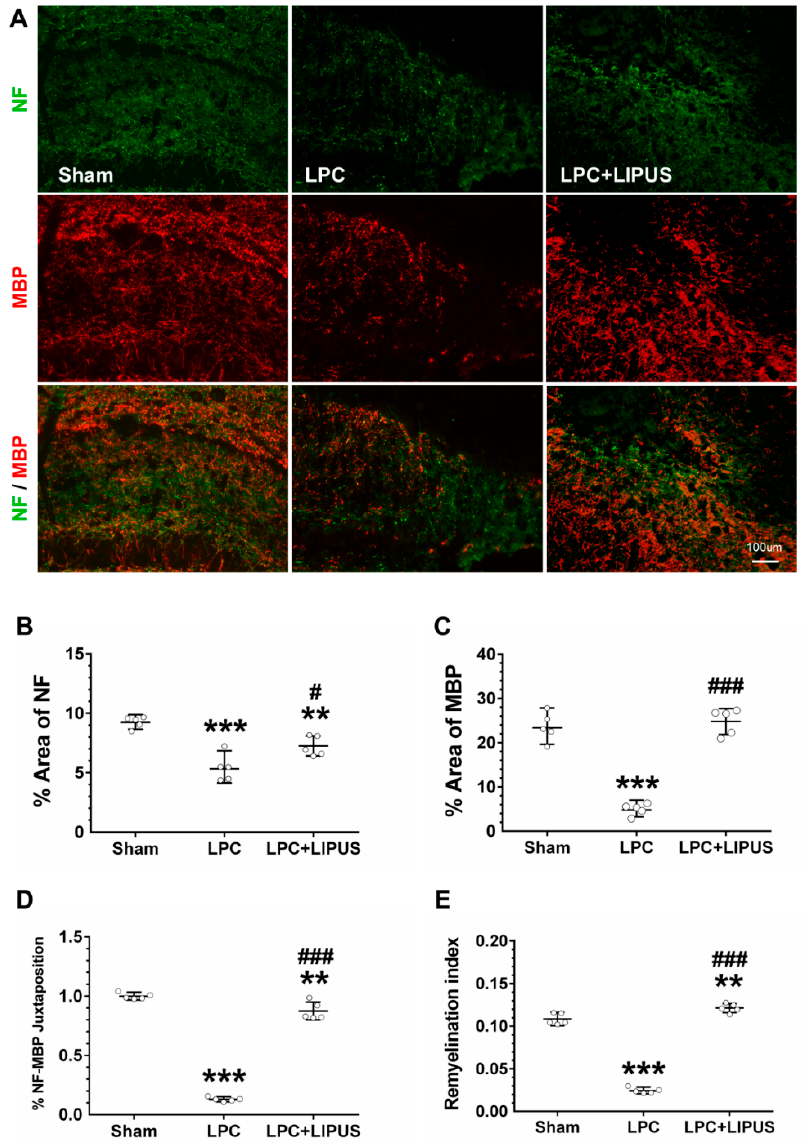
Figure 1. Evaluation of lesion size and axonal integrity 7 days after LPC-induced demyelination. ( A ) Immunofluorescent images of NF (green) and MBP (red) at the demyelination lesion in the hippocampus. ( B ) The percentage area covered by NF + fibers. ( C ) The percentage area covered by MBP + fibers. ( D ) The percentage of juxtaposed NF + and MBP + fibers. ( E ) The LIPUS-treated rats had a significantly higher remyelination index compared with the sham and LPC-treated rats. * and # denote significant differences from the sham and the LPC groups, respectively (**, p < 0.01; ***, p < 0.001; # , p < 0.05; ### , p < 0.001, n = 5). Scale bar = 100 μ m. LPC: lysolecithin, LIPUS: low-intensity pulsed ultrasound, NF: neurofilament, and MBP: myelin basic protein.